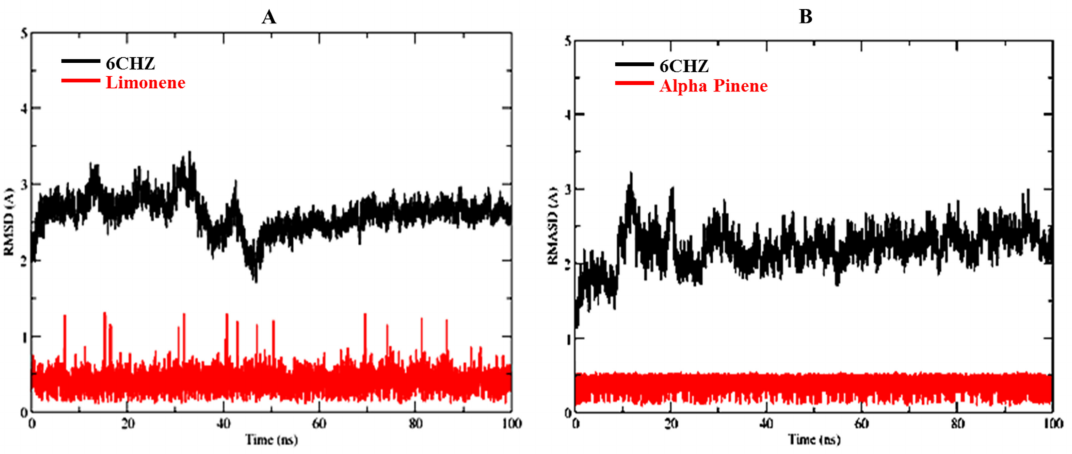
Figure 4. RMSDs of protein-ligand complexes: ( A ) D-limonene with 6CHZ and ( B ) Alpha-pinene with 6CHZ. Red indicates ligand and black indicates C-alpha of the target protein.